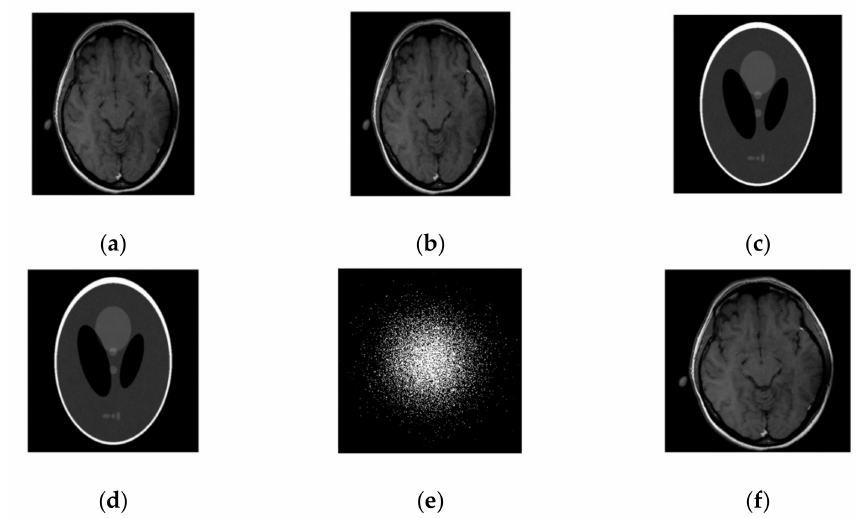
Figure 4. Images recovery in a noisy case. ( a ) Recovered MR image of a brain by SiFo; ( b ) Recovered MR image of brain by DLMRI; ( c ) Recovered MR image of phantom by SiFo; ( d ) Recovered MR image of a phantom by DLMRI; ( e ) sampling mask in k -space with 10 fold; ( f ) Reference MR image of a brain.